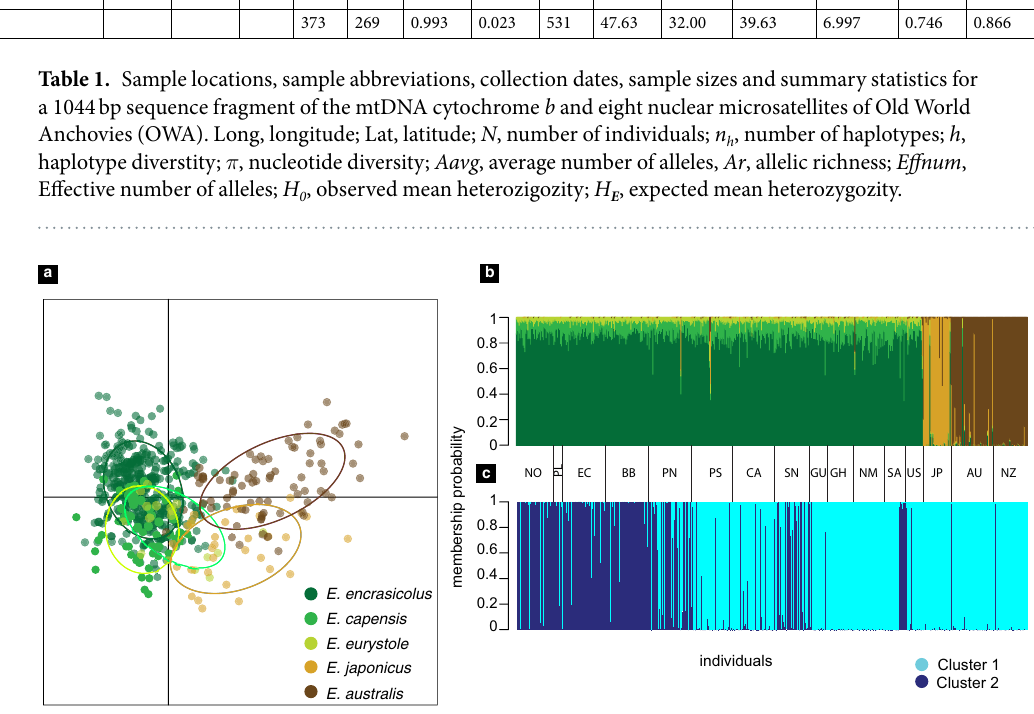
Figure 2. ( a ) Discriminant analysis of principal components (DAPC) of multi-locus Old World Anchovies genotypes; individual genotypes appear as circles; ellipses represent the centre of dispersion of each putative species (see Fig. 1 and Table 1). Horizontal and vertical axes are the first two principal components, respectively; ( b ) scatter plot of a priori -defined nominal species; ( c ) individuals assigned to their genetic cluster without forcing them into pre-determined